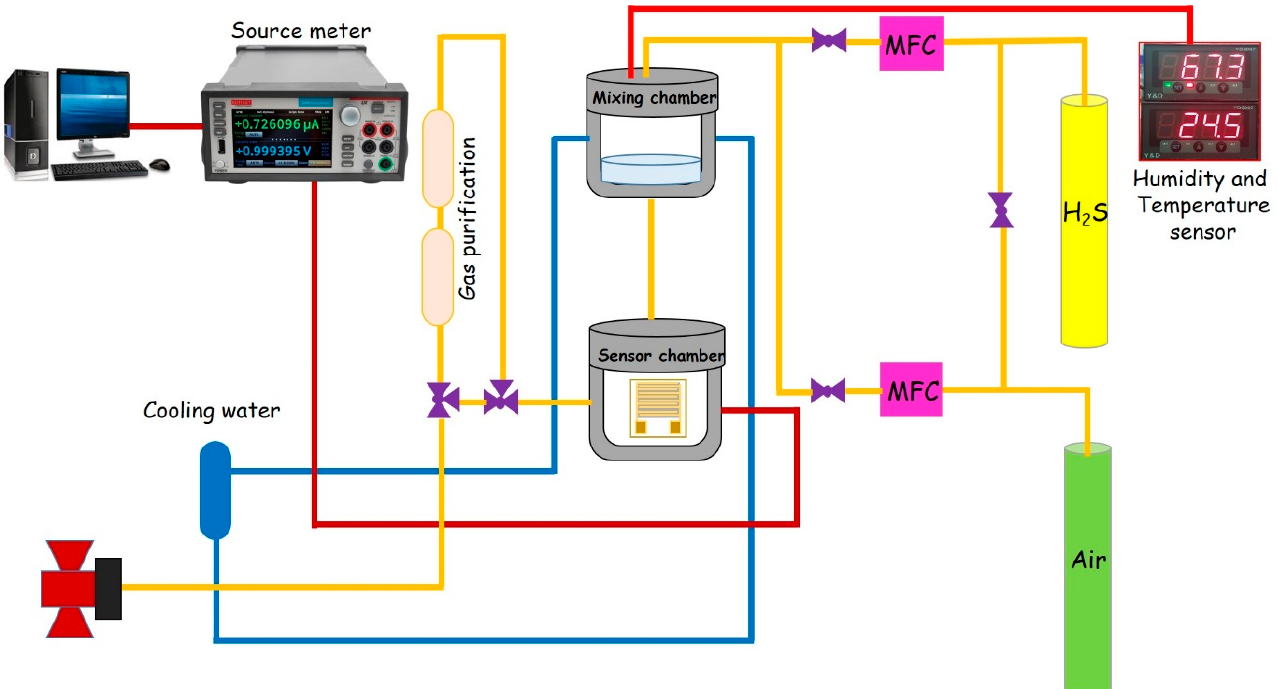
Figure 2. Schematic representation of the gas-sensor measurement setup .